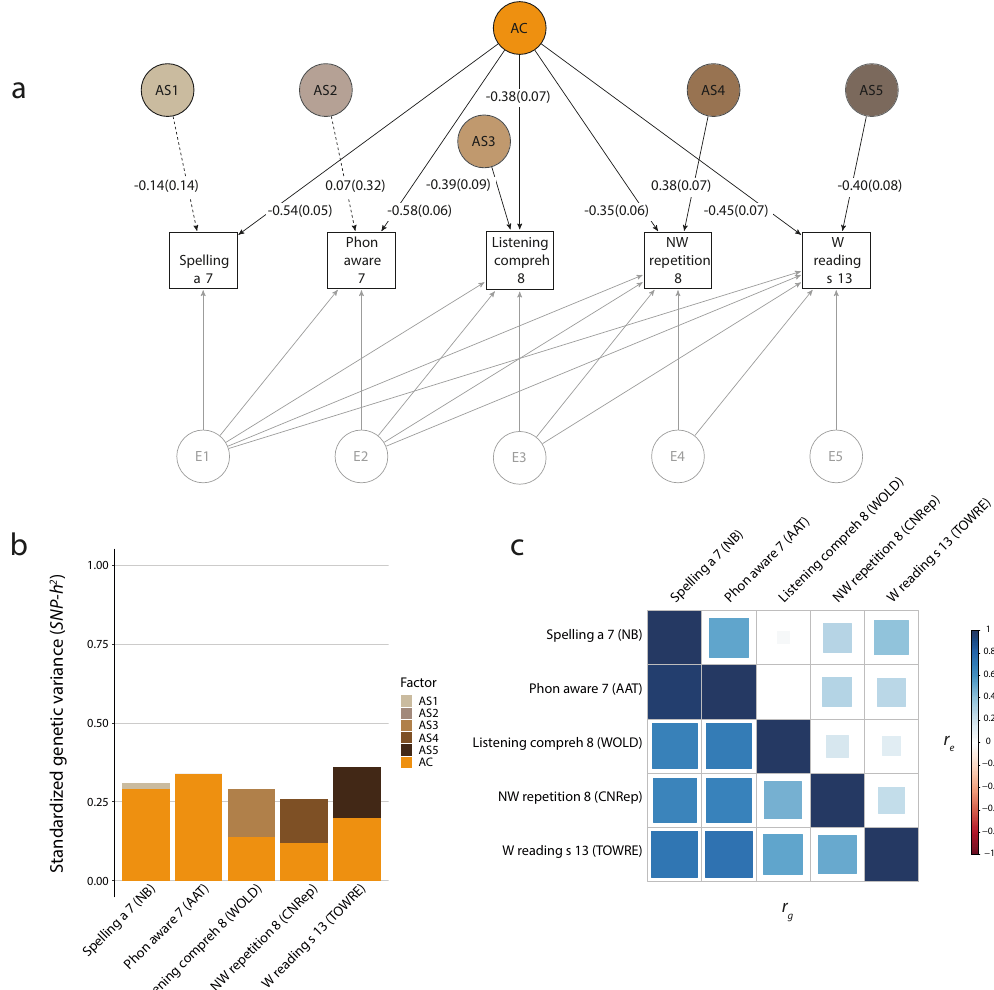
Fig. 3 Multi-domain structural model (Word reading subset). Genetic-relationship matrix structural equation modeling (GSEM) of literacy, phonological awareness, language and PWM abilities ( N = 6383). The path diagram ( a ) depicts the genetic factors of the best- fi tting model (IPC model) describing variation in spelling accuracy at age 7 (Spelling a 7, NB), phonemic awareness at age 7 (Phon aware 7, AAT), listening comprehension at age 8 (Listening compreh 8, WOLD), non-word repetition at age 8 (NW repetition 8, CNRep), and word reading speed at age 13 (W reading s 13, TOWRE). The phenotypic variance was dissected into common (AC) and speci fi c (AS1-AS5) genetic factors, according to an Independent Pathway model, as well as residual factors (E1-E5), based on a Cholesky decomposition (Factor loadings not shown, Supplementary Table 17, and Supplementary Fig. 4). Observed measures are represented by squares and factors by circles. Single-headed arrows (paths) de fi ne relationships between variables. Dotted and solid paths represent factor loadings with p > 0.05 and p ≤ 0.05 respectively. The variance of latent variables is constrained to unit variance; this is omitted from the diagram to improve clarity. The variance plot ( b ) depicts the standardized genetic variance components for the model in a . The correlogram ( c ) shows genetic ( r g , lower triangle) and residual ( r e , upper triangle) correlations for the model in a . Point estimates and their SEs are reported in Supplementary Table 20. All measures were rank-transformed. IPC model – Combined Independent Pathway/Cholesky correlations between word reading speed and other phenotypes suggested a marginally better fi t of the IPC model, based on AIC, were still moderate to high; they were 0.52 (SE = 0.11) with BIC and LRTs (Table 4 and Supplementary Tables 17 – 20). Thus, listening comprehension, 0.50 (SE = 0.10) with non-word repeti- consistent genetic factor structures between reading fl uency, tion, 0.72 (SE = 0.10) with spelling and 0.74 (SE = 0.10) with spelling, phonemic awareness, listening comprehension and non- phonemic awareness (Fig. 3c and Supplementary Table 20). word repetition (Supplementary Tables 15 and 19) could be A sensitivity analysis con fi rmed that the bivariate genetic robustly identi fi ed using different multivariate structural models, correlations estimated with GSEM and GCTA, were nearly identical irrespective of the genetic composition of the selected reading fl uency measure. However, in contrast to the model for the (Supplementary Tables 3 and 4). Furthermore, all multivariate GSEM- SNP-h 2 (Supplementary Tables 8, 12, 15, and 19) were passage reading dataset, the shared factor only captured 56% (SE = 0.14) of the SNP-h 2 for word reading speed (age 13), while consistent with univariate GCTA SNP-h 2 estimates (Supplementary the remaining 44% (SE = 0.14) were captured by a trait-speci fi c Table 1), based on derived 95% con fi dence intervals (CIs). factor (Supplementary Table 18). This pattern mirrors the large Lastly, we compared multivariate genetic and residual trait speci fi c factor for word reading speed estimated with the Stage 1 correlation patterns as fi tted by IPC models. Among reading fl uency measures (Fig. 1c), and extending to spelling accuracy and reading fl uency model (Fig. 1a). Nonetheless, estimated genetic